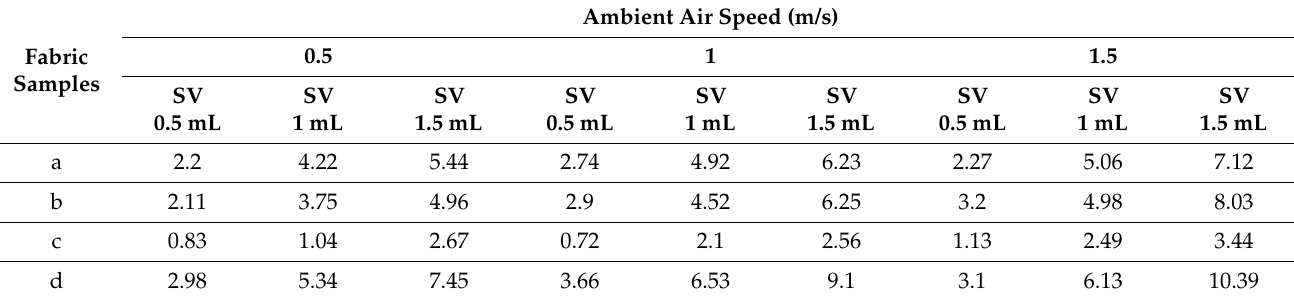
Table 4. Sweat drying performance of the selected fabrics under different ambient